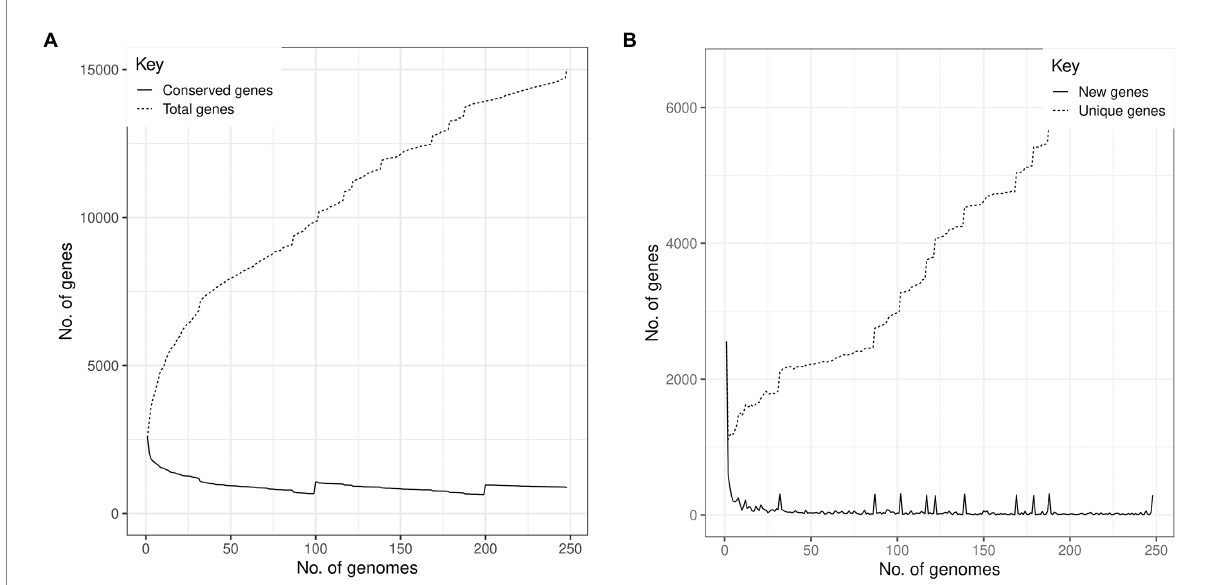
FIGURE 3 Staphylococcus aureus pangenome profile isolated from humans (abscesses, skin infections, and pus) and from cattle (clinical mastitis, subclinical mastitis, and raw milk). (A) The number of genes as a function of the number of genomes. The solid line indicates the number of conserved genes in the core genome and the dashed line the total number of genes. (B) The number of new pangenome genes as a function of the number of analyzed genomes. The solid line indicates the number of new genes and the dashed line, the total number of unique genes.